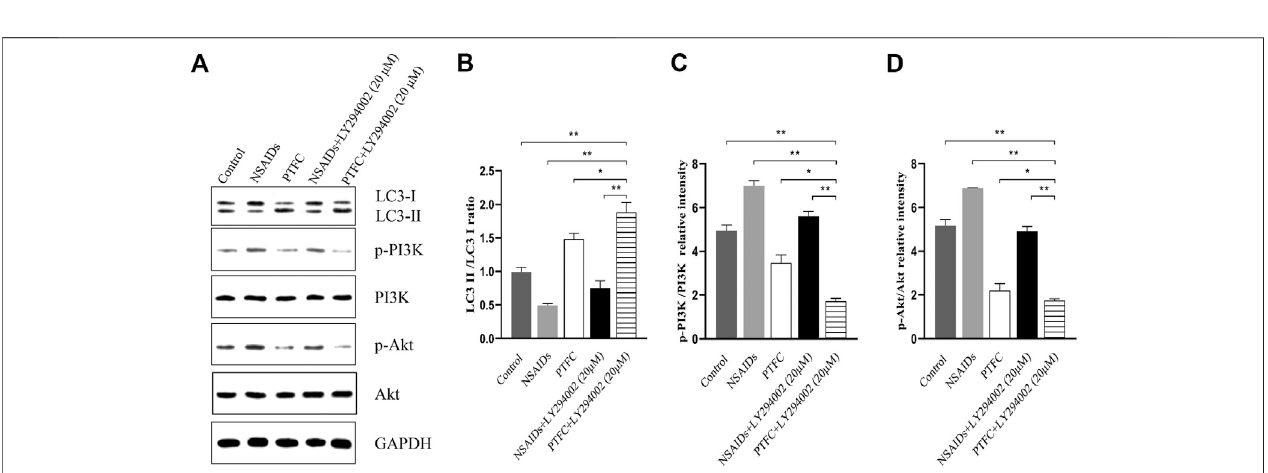
FIGURE 8 | PTFC increases autophagy through PI3K/Akt Signaling in IEC-6 cells (A) Western blot analysis was performed to determine expression levels of levels of light chain 3 (LC3), phosphoinositide 3-kinase (PI3K), phosphorylated-PI3K (p-PI3K), Akt, and phosphorylated-Akt (p-Akt) (B – D) Density ratios of LC3-II/LC3-I and phosphorylated/unphosphorylated proteins (p-PI3K/PI3K, p-Akt/Akt) were calculated using ImageJ software. Glyceraldehyde 3-phosphate dehydrogenase (GAPDH) was used as a loading control (* p < 0.05 and ** p <